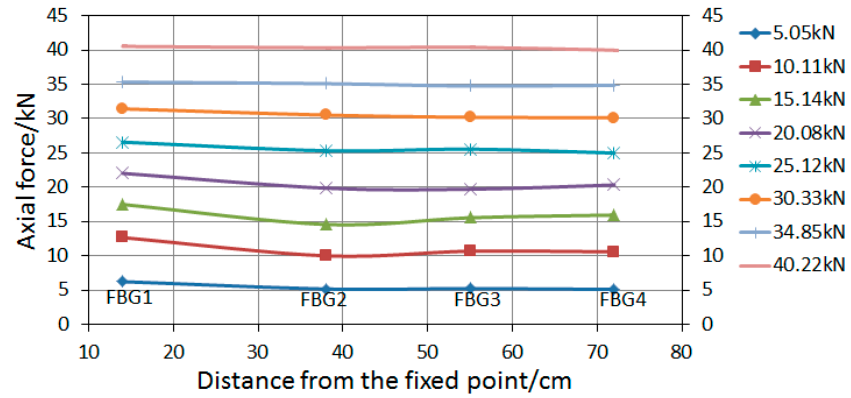
Figure 19. The variation curve of the axial force of the bolt-shaft in “Passive”.